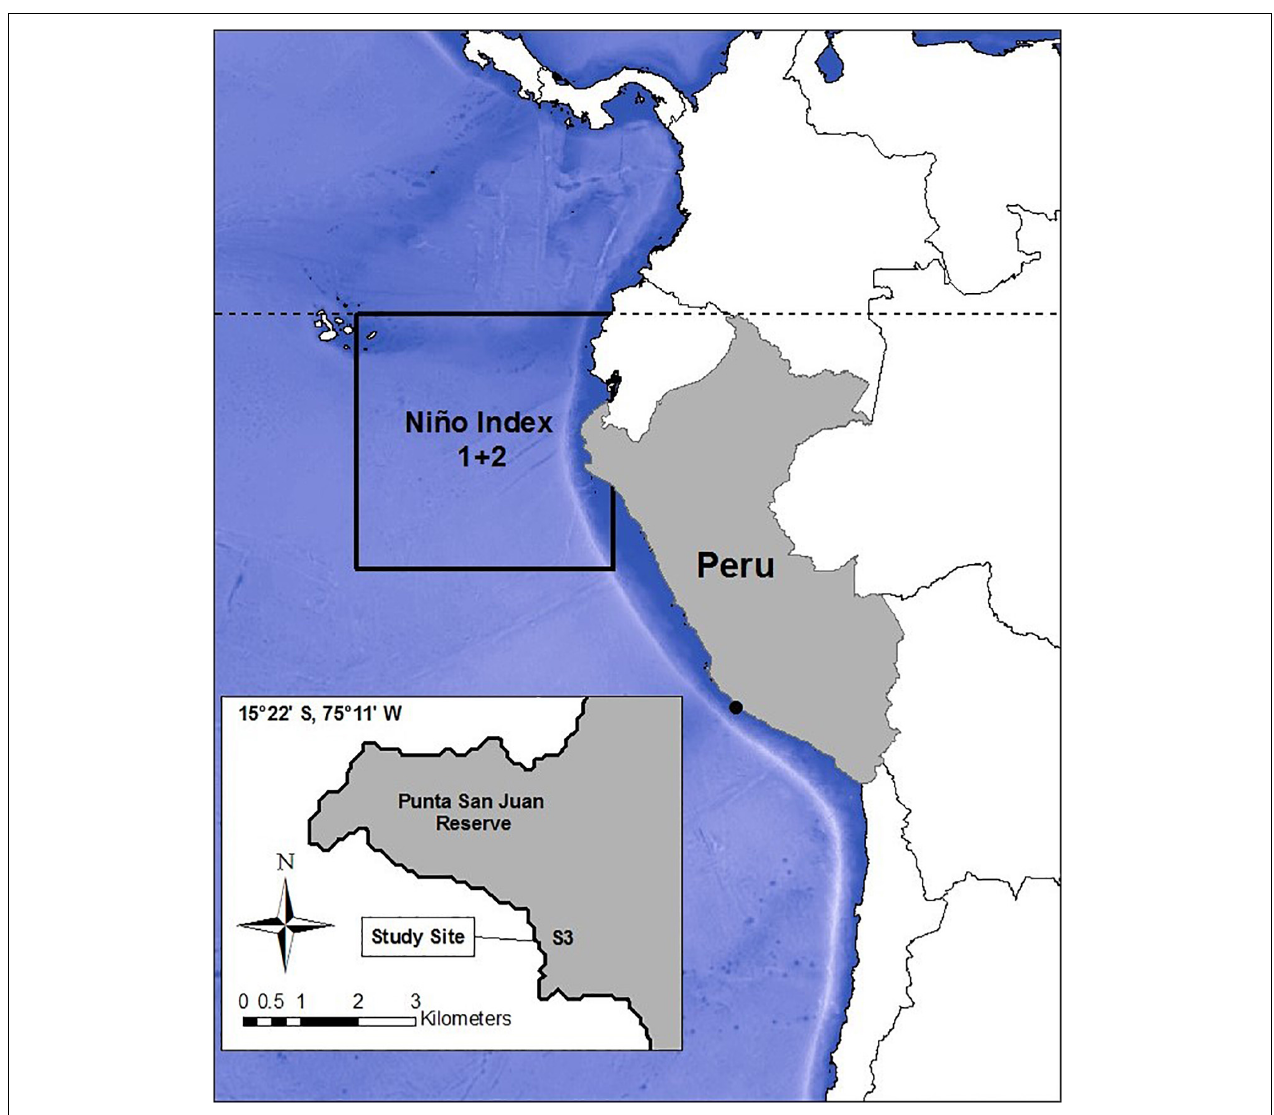
FIGURE 1 | Location of the Punta San Juan reserve (PSJ) in Peru (shaded in gray), and an insert of PSJ with the beach used as the study site (S3), the main breeding colony of Peruvian fur seals. The black square represents the region of coastal waters of Niño Index 1 + 2 found along the equator, characterized by the dashed line. (Map adapted from Cárdenas-Alayza,